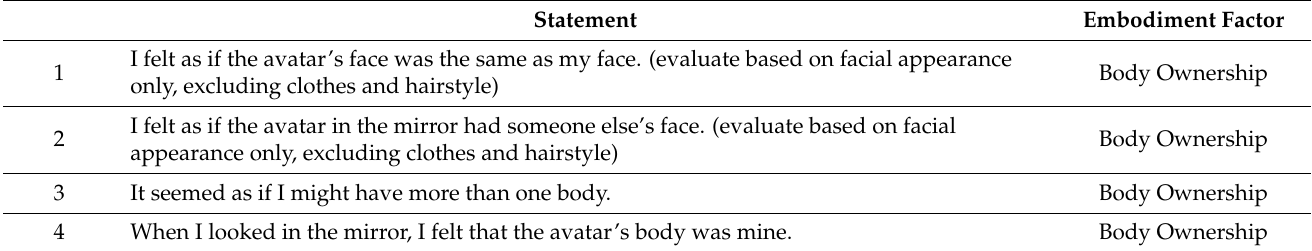
Table A2. Embodiment questionnaire statements (seven-point scale) adapted from Gonzalez-Franco and Peck